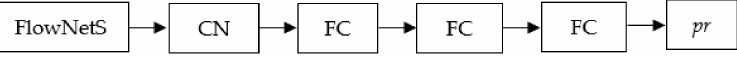
Figure 9. Adaptive scheduling